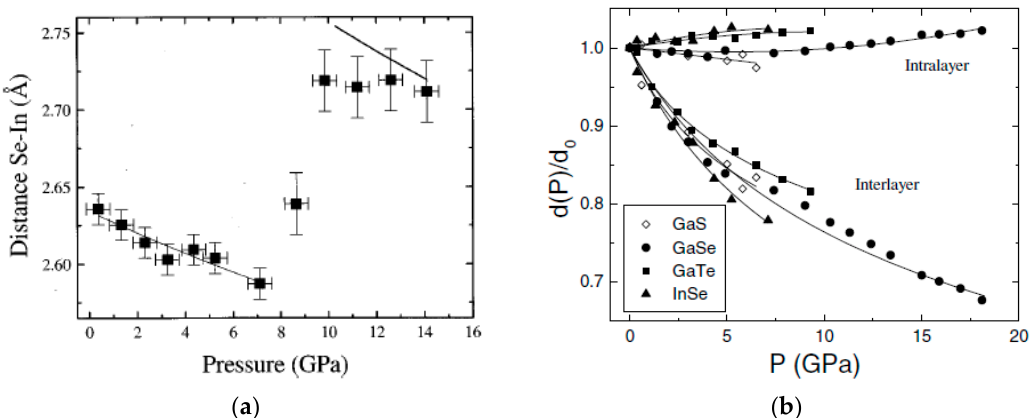
Figure 3. ( a ) Pressure dependence of the InSe bond-length as obtained from EXAFS measurements [31]. ( b ) Relative variation of the layer thickness (intralayer) and the Van der Waals gap (interlayer) as a function of pressure [37].